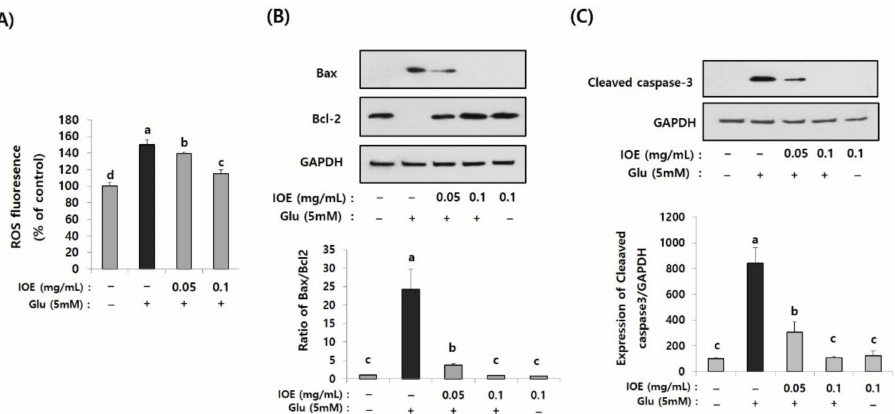
Figure 8. Glutamate-induced intracellular reactive oxygen species (ROS) and apoptosis were inhib- ited by IOE. Glutamate-mediated ROS production was dose-dependently inhibited by IOE adminis- tration in HT22 cells ( A ). Expression of apoptosis-related genes (Bax, Bcl-1, and cleaved caspase-3) were estimated by Western blotting ( B , C ) ( n = 3). The density of each band was estimated by the ImageJ program, and the ratio of Bax/Bcl-2 and the relative expression of cleaved caspase-3 (cleaved caspase-3/ β -actin) was calculated and tabulated. Data shown are means ± SD. Glu: Glutamate. Non-treated cells (IOE- and Glu-) were used for the control. Experiments were conducted in triplicate and repeated three times with similar results. a: significant differences ( p < 0.05) when